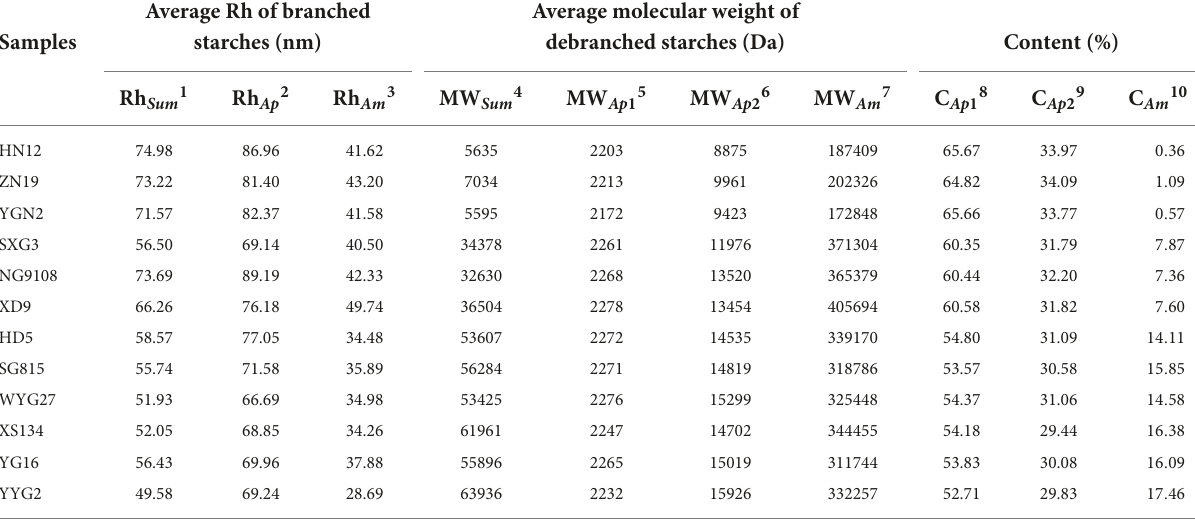
TABLE 1 Starch structural parameters of whole branched starch and debranched starch extracted from japonica rice. Average Rh of branched Average molecular weight of Samples